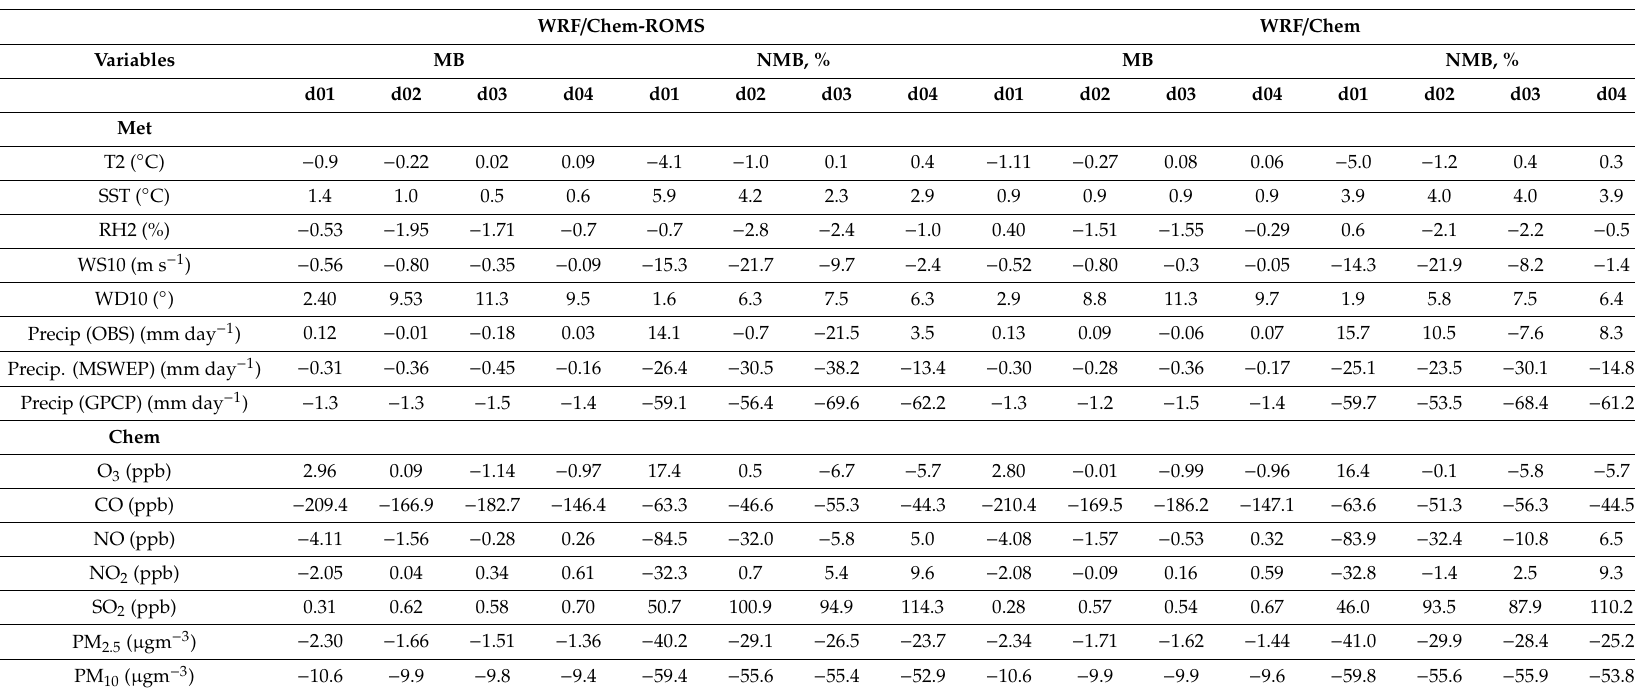
Table 1. Mean bias (MB) and normalized mean bias (NMB) of meteorological and chemical variables from WRF / Chem and WRF / Chem-ROMS simulations at 81 km (d01), 27 km (d02), 9 km (d03), and 3 km (d04) over the 3 km domain (d04) for the SPS1 field campaign. WRF / Chem-ROMS